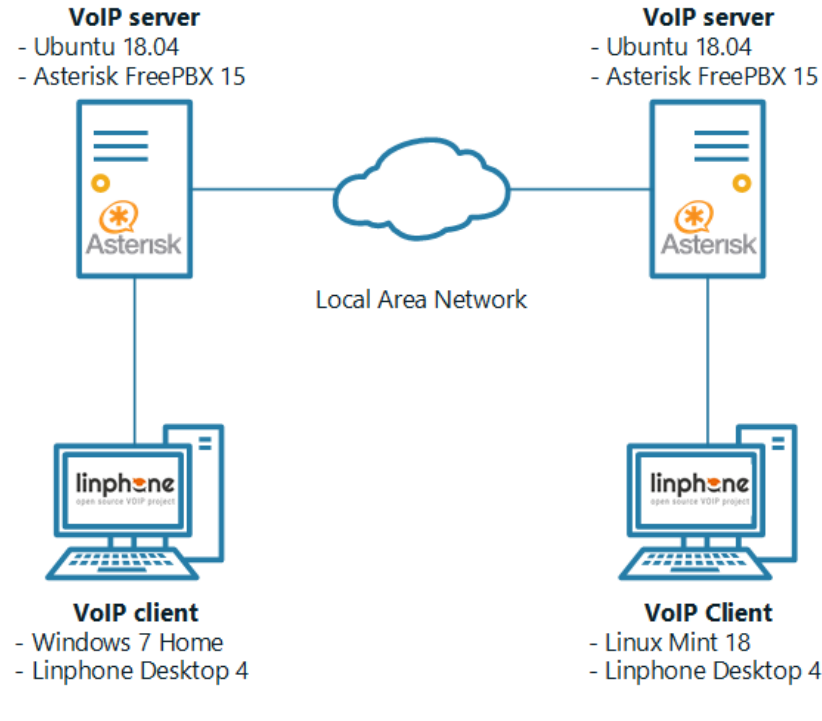
Figure 27: Presentation of paper